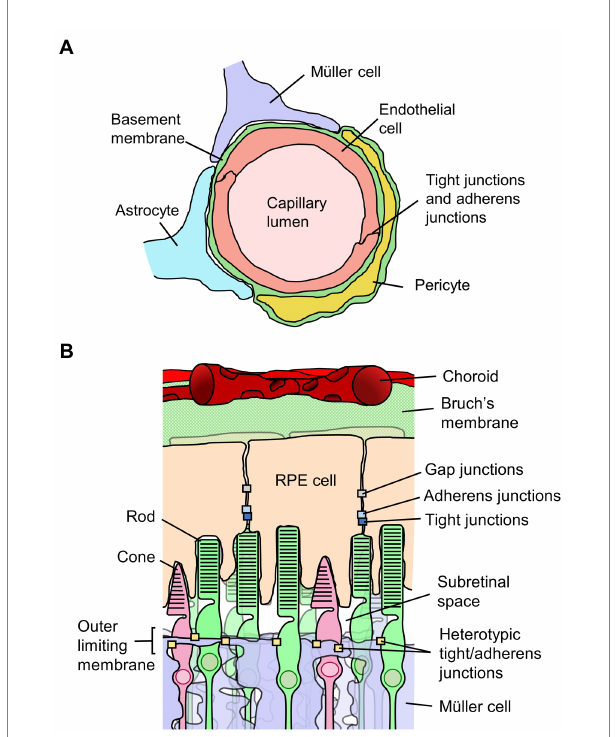
FIGURE 2 Diagrams of the inner and outer blood-retinal barriers (BRB). (A) Schematic cross-section of a retinal capillary indicating the location of junctions between retinal endothelial cells which form the inner BRB, along with surrounding cell types. (B) Diagram of the outer portion of the retina and choroid, indicating the junctions between retinal pigment epithelial (RPE) cells which form the outer BRB, along with surrounding